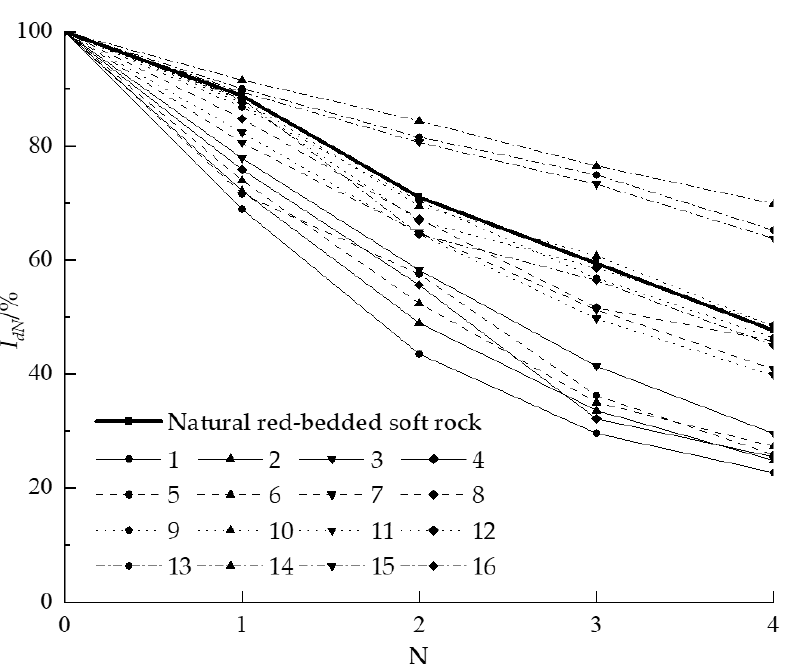
Figure 7. Relationship between disintegration resistance index and the number of dry–wet cycles for each specimen. Table 6. Physical and mechanical properties of similar materials. Experiment